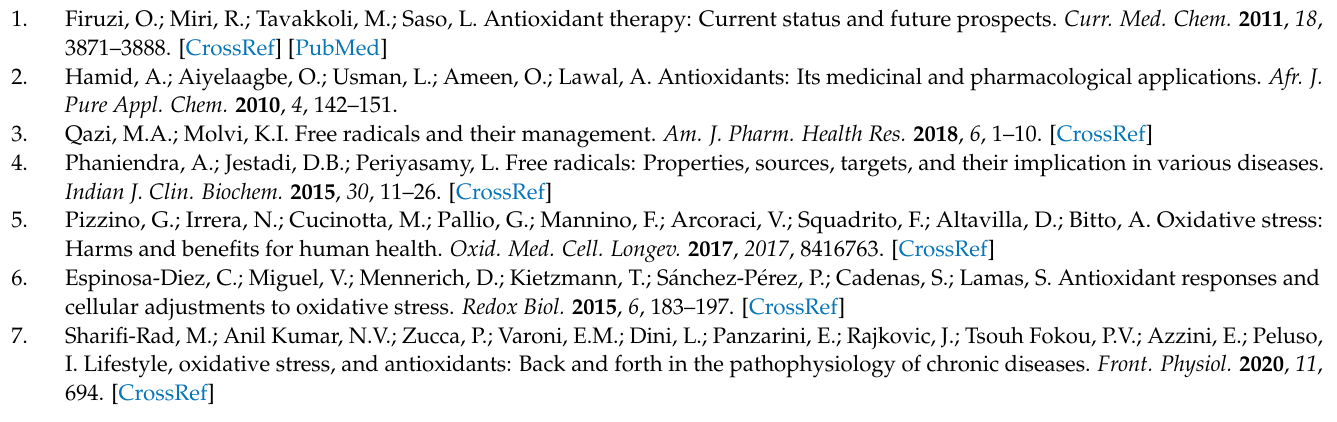
leaves; Figure S3. P. hispidum plant and leaves; Figure S4. P. longum leaves and mature dried corns; Figure S5. P. umbellatum plant and leaf; Figure S6. The structure chemical compound of P. amalago ; Figure S7. The structure chemical compound of P. betle ; Figure S8. The structure chemical compound of P. hispidum ; Figure S9. The structure chemical compound of P. longum ; Figure S10. The structure chemical compound of P. umbellatum ; Figure S11. The chemical structure of synthetic